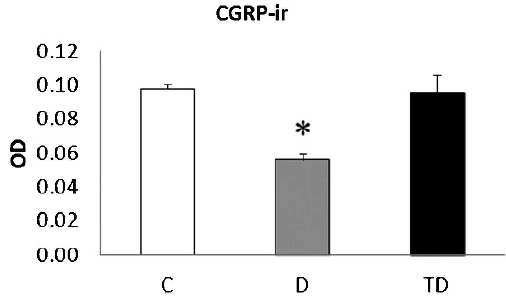
Figure 2 - CGRP immunoreactivity (CGRP-ir) in the dorsal horn of the spinal cord from the C, D and TD animals. ANOVA with Bonferroni’s post hoc test. * corresponds to p , 0.05 compared with the C and TD